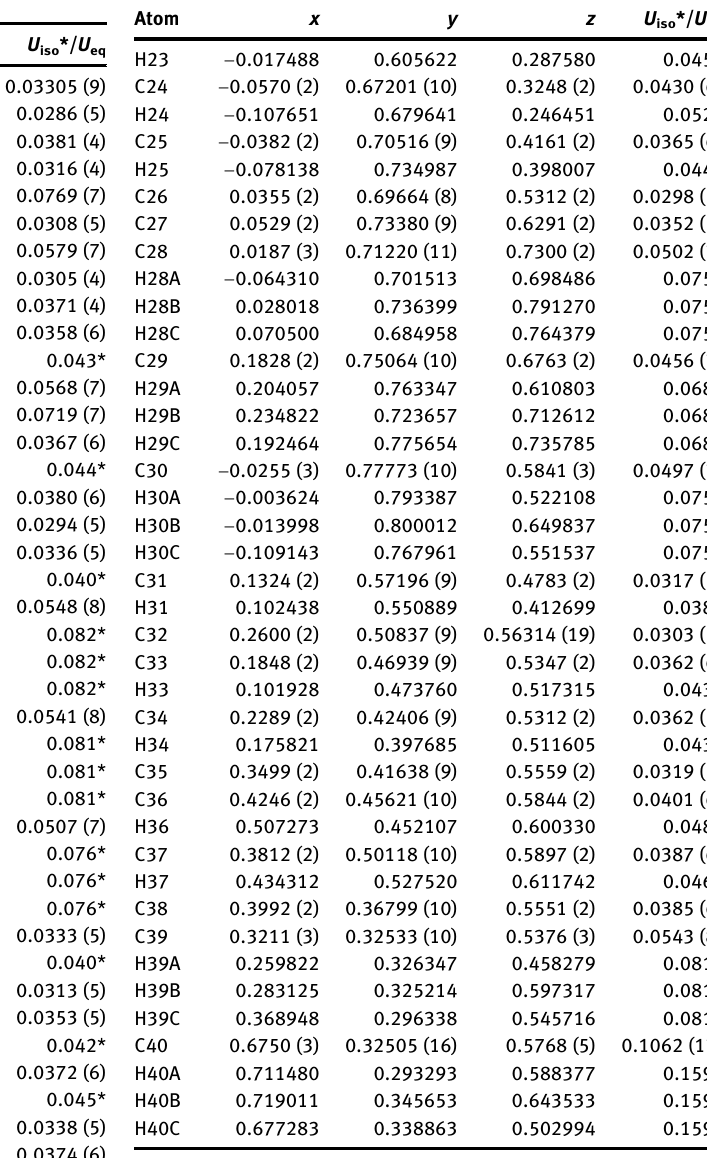
Table  : Fractional atomic coordinates and isotropic or equivalent isotropic displacement parameters (Å 